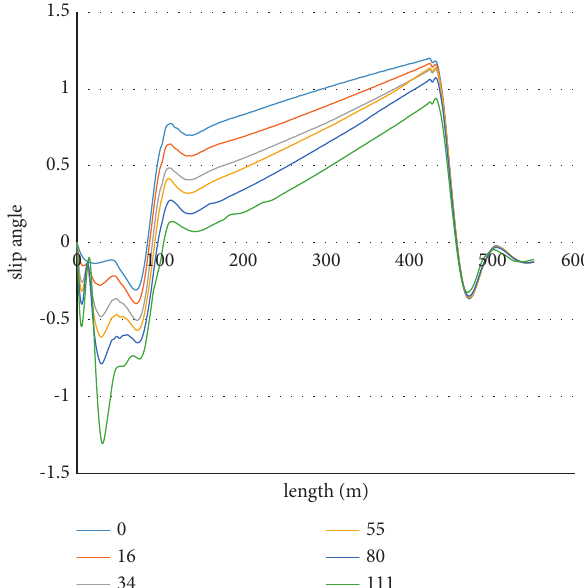
Figure 22: Comparison of slip angle along the path at different wind speeds.